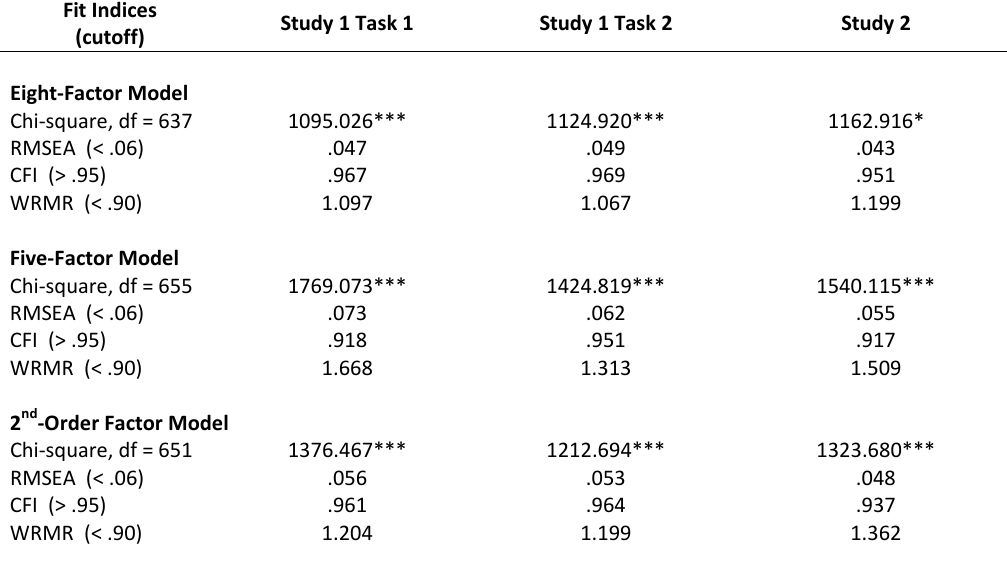
Table 2. Confirmatory Factor Analyses Fit Indices